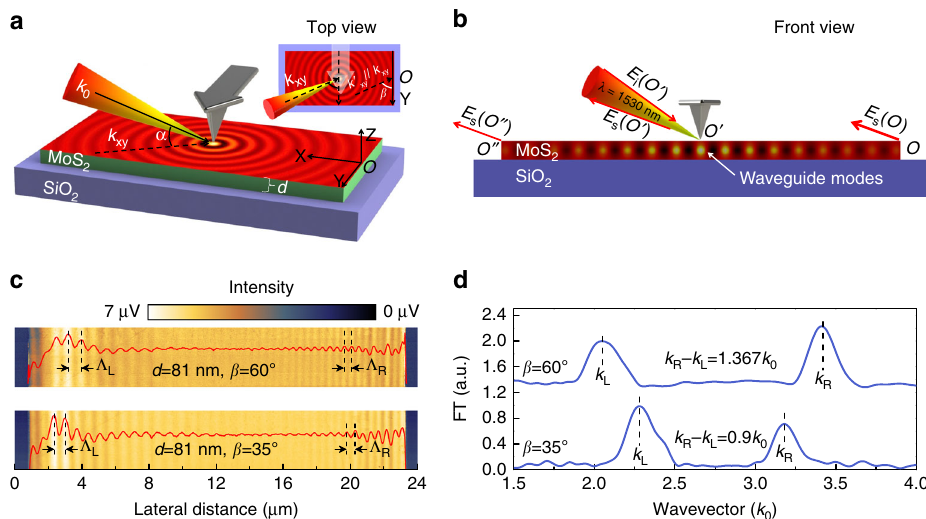
Fig. 1 Schematics of the experimental setup and the near- fi eld imaging principle. a Three-dimensional schematic of the near- fi eld setup. The sharp edges of MoS 2 nano fl akes are aligned to the Y axis and the s-SNOM tip scans along the X axis. Inset is the top view of the experimental setup. α is the angle between the illumination wavevector k 0 and its projection in the X – Y plane k xy , β is the angle between k xy and the investigated sample edges. b Front view of the experimental setup. The tip-launched waveguide modes are scattered into free space at the sample edges and interfere with the tip-scattered light at the photodetector. c Near- fi eld images and real-space fringe pro fi les of the 81-nm-thick MoS 2 sample with β = 60°and β = 35°, respectively. Λ L is the fringe spacing at the left half of the near- fi eld images while Λ R is that at the right half. d Momentum – space spectra of the fringe pro fi les in c , the difference between the left and right side apparent wavevectors decreases with the reduction of